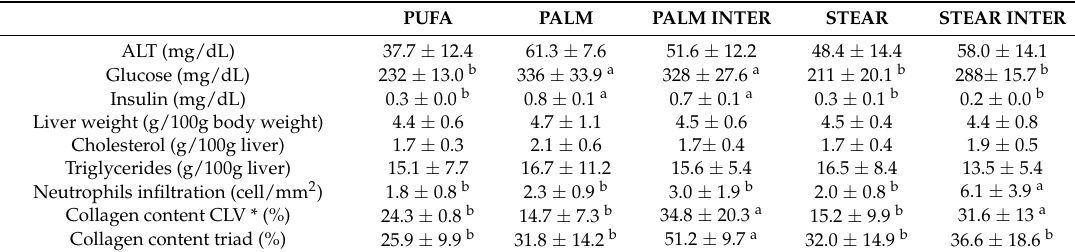
Table 3. Plasma parameters, relative weight of liver, cholesterol and triglycerides content, neutrophils infiltration, and collagen content in LDLr-KO mice fed experimental diets for 16 weeks. PUFA PALM PALM INTER STEAR STEAR INTER